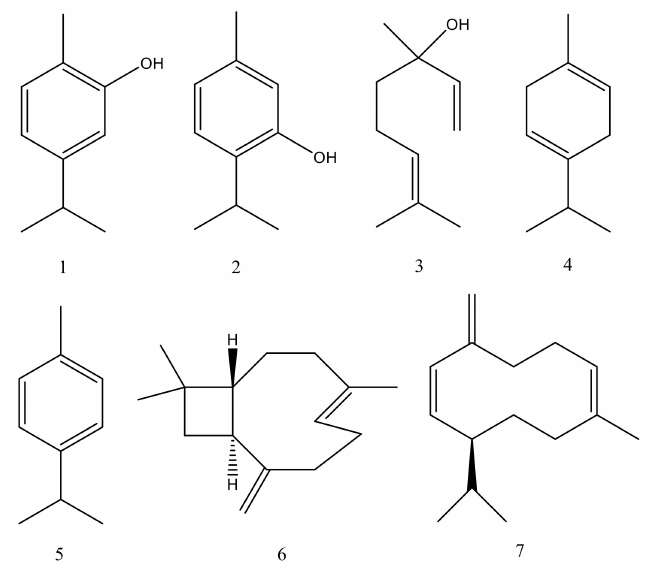
Figure 2. Chemical structures of main constituents of Origanum vulgare essential oil: (1) Carvacrol, (2) Thymol, (3) Linalool, (4) γ -Terpinene, (5) p -Cymene, (6) β -Caryophyllene, (7) Germacrene